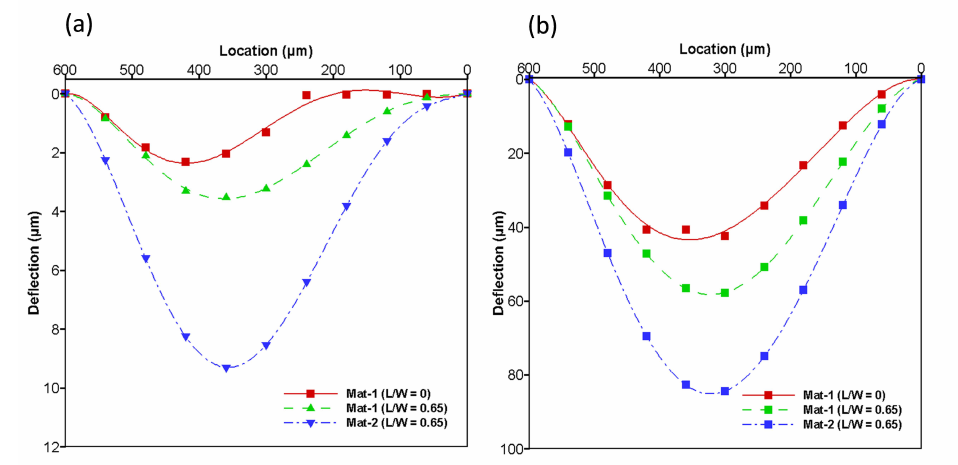
Figure 12. Deformation of membrane in the A-A’ cross-sectional plane is shown in various material properties at an input flow rate of 8 µ L/min are used in both L/W-ratio models ( a ) L/W = 0 and ( b ) L/W = 0.65 model.